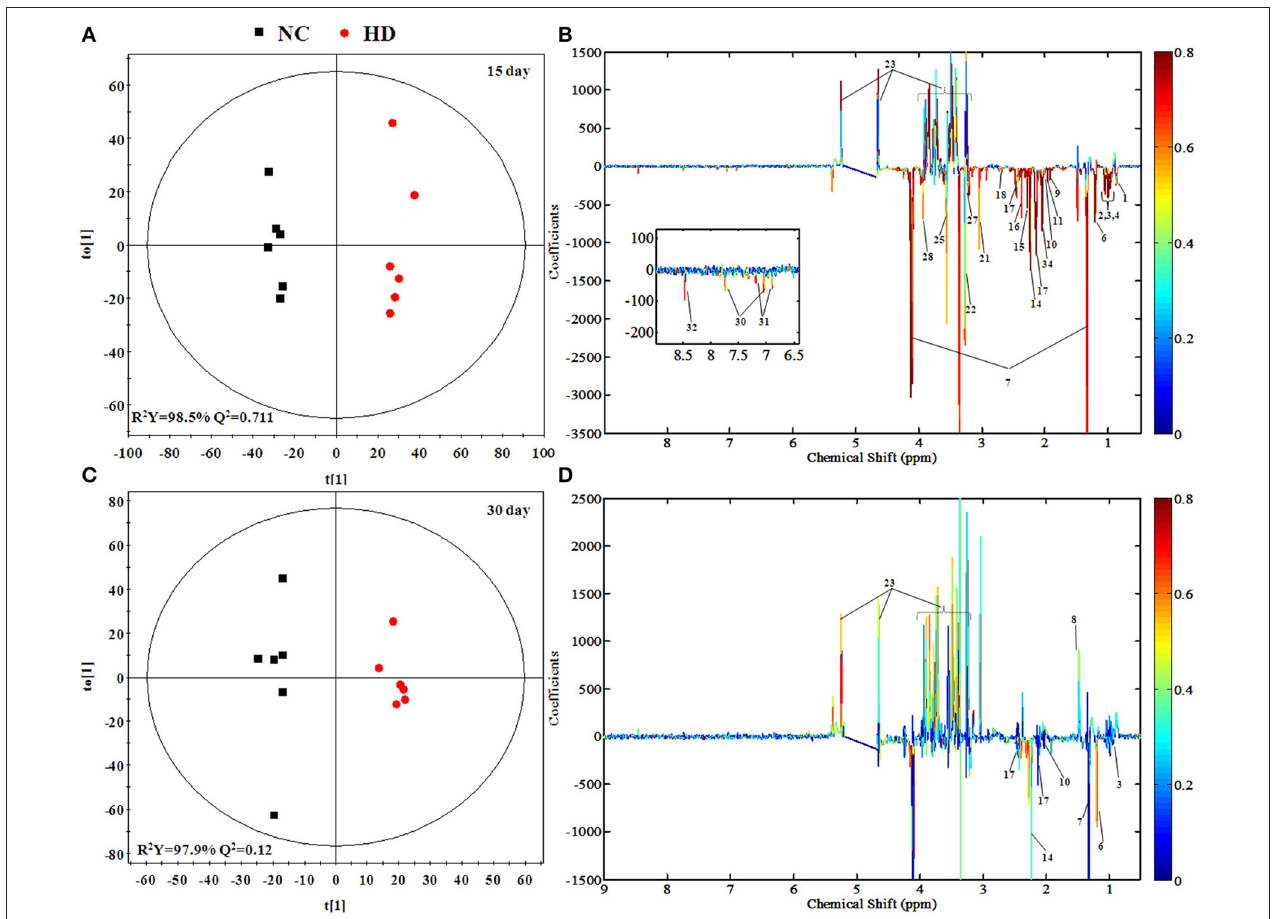
FIGURE 4 | OPLS-DA scores plots (A,C) and coefficient loading plots (B,D) derived from 1 H NMR spectra of plasma from HD and NC group at day 15 and day 30. The color code corresponds to the correlation coefficients of the metabolic variables. The loading plots identifying discriminatory metabolites between HD and NC group are based on the first principal component [ t (1) ]. Signals with a positive direction relate to the abundance of metabolites in the groups in the positive direction of [t (1) ], and vice